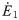
Variance of the noise in the state space of the two competing excitatory subnetworks.
A. Variance of E.1 and B. Variance of E.2 in the state space spanned by E
1 and E
2.